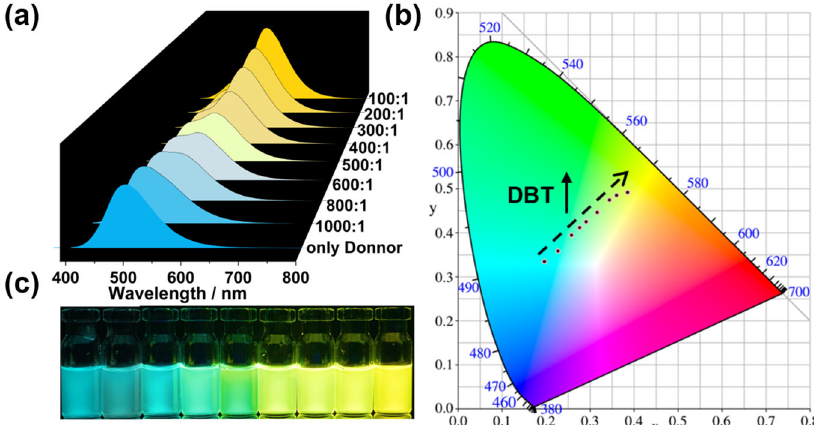
Figure 4. ( a ) The fluorescence spectra of M in water with different concentrations of DBT . ( b ) The CIE chromaticity diagram of photoluminescence color changes by varying the ratios of the chromophores. ( c ) Photographs of NPs in water with different M/DBT ratios. [ M ] = 5 × 10 − 5 M.